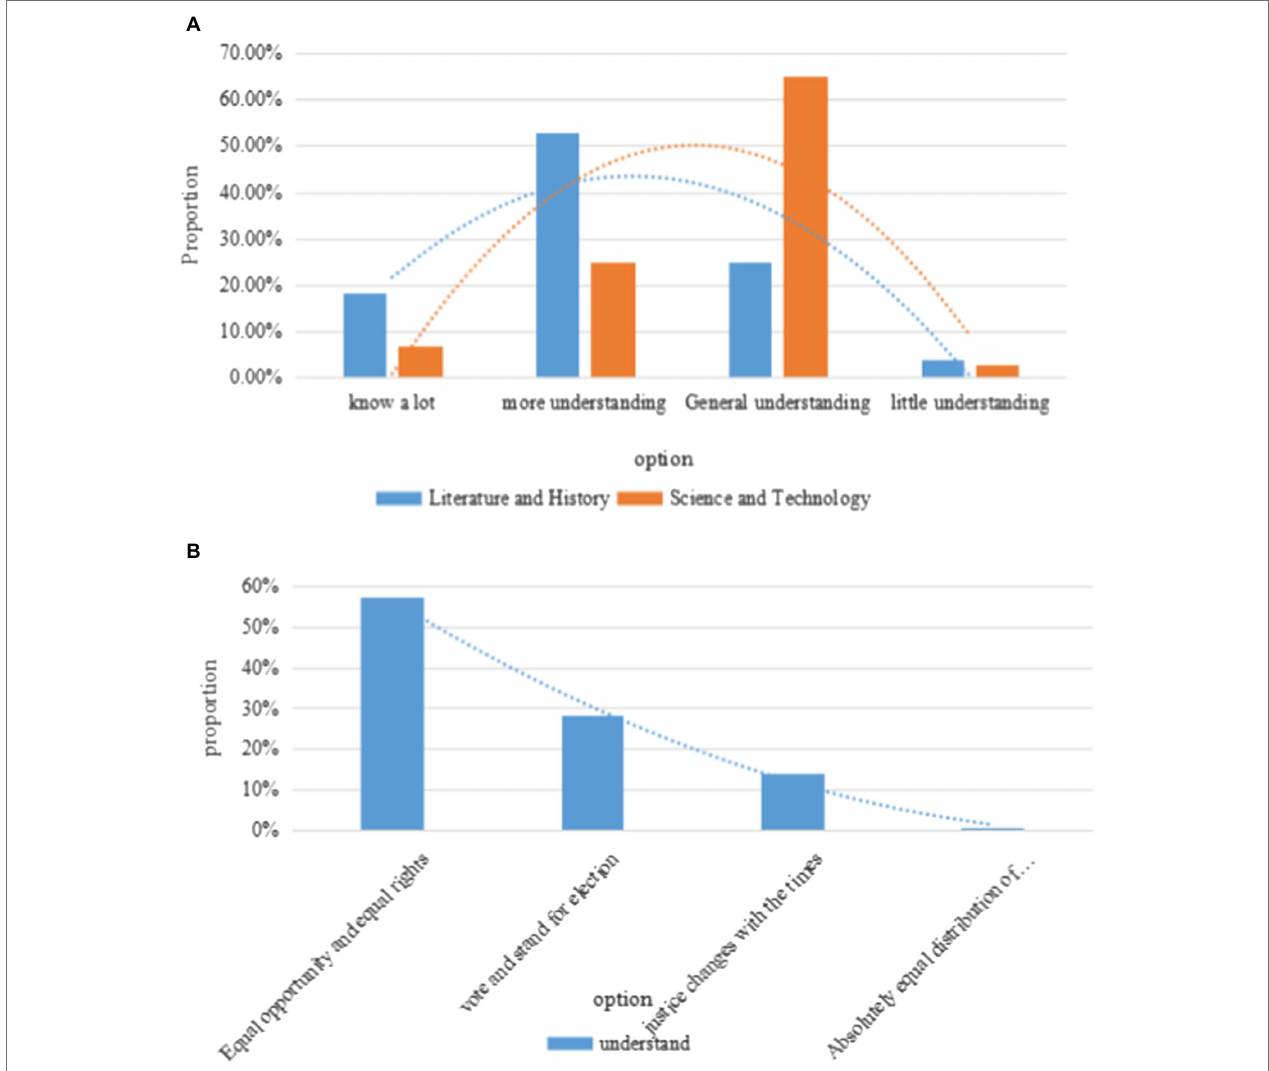
FIGURE 7 | Different majors’ understanding of the concept of justice and its connotation. (A) Knowledge of the concept of justice. (B) Understanding of the connotation of the concept of justice.